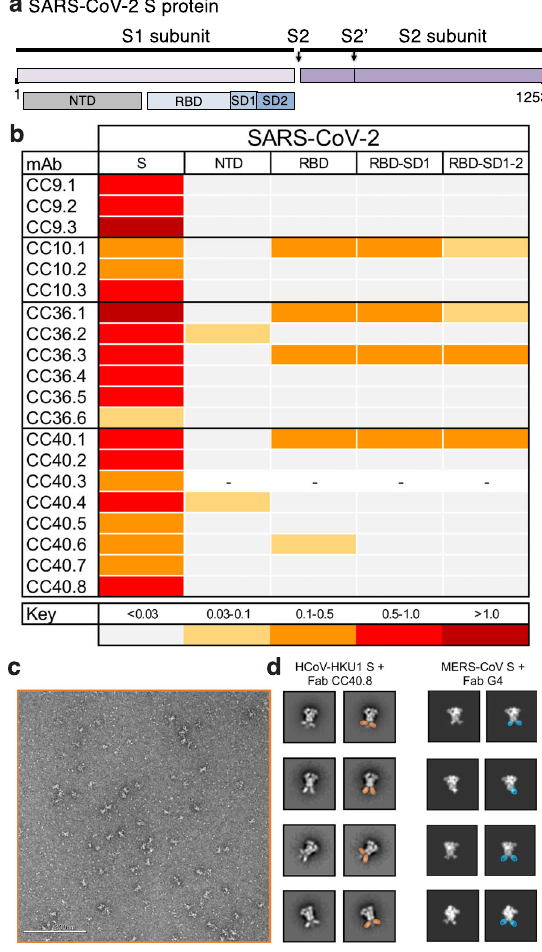
Fig. 5 Epitope speci fi cities of SARS-CoV-2 and endemic HCoV S-protein speci fi c cross-reactive mAbs. a – b Organization of SARS-CoV-2 S protein subunits, domains, and subdomains ( a ). Epitope mapping of the mAbs binding to domains and subdomains of SARS-CoV-2 S-protein, NTD, RBD, RBD-SD1, and RBD-SD1-2 and heatmap showing BLI responses for each protein. The extent of binding responses is color-coded ( b ). Five mAbs were speci fi c for RBD, two for NTD and the remaining mAbs displayed binding only to the whole S protein. c – d Negative stain electron microscopy of HCoV-HKU1 S-protein + Fab CC40.8 complex and comparison with MERS-CoV S + Fab G4 complex. c Raw micrograph of HCoV-HKU1 S in complex with Fab CC40.8. The Fab-HCoV-HKU1 S protein complexing was performed twice, and the data is representative of the two experiments. d Select reference-free 2D class averages with Fabs colored in orange for Fab CC40.8 and blue for Fab G4, which in 2D appear to bind a proximal epitope at the base of the trimer. 2D projections for MERS-CoV S-protein in complex with Fab G4 were generated in EMAN2 from PDB